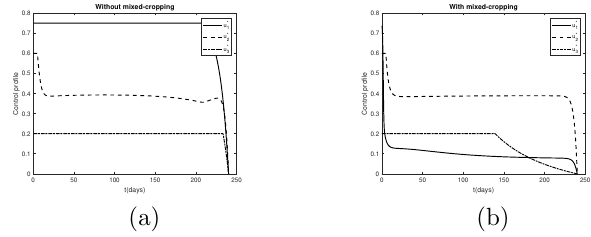
Figure 5. Plots of the optimal controls u ∗ ,u ∗ and u ∗ as functions of time without (a) 1 2 3 and with (b) mixed-cropping strategy. The graphs are results of the parameters values m 1 = 100 , m 2 = 80 , n 1 = n 2 = 10 , 000 , n 3 =